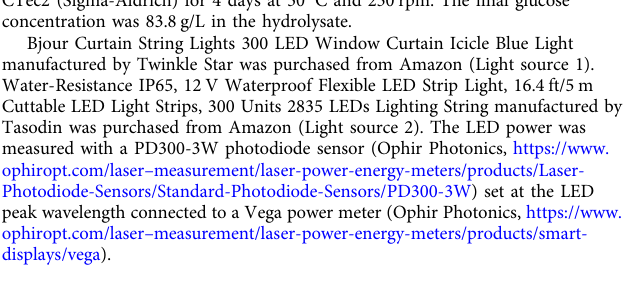
Table 4. After each transformation or knockout, colony PCR-positive Y. lipolytica strains were further screened by microplate fermentation. Brie fl y, 12 positive strains were inoculated to 12-well microplate containing 2mL YEM medium in each well and cultivated in dark at 30 °C, 225 rpm for 2 days, followed by cultivation in blue